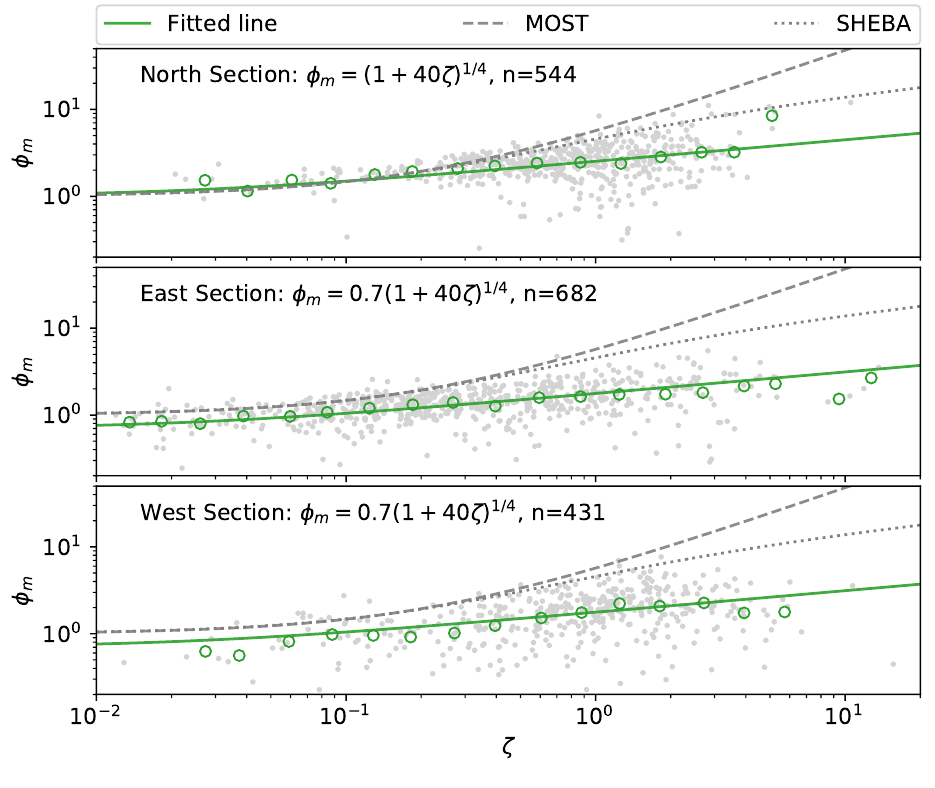
Figure 6. Plots of φ m of different models as functions of ζ : dots (measured data) and circles (bin-averaged measured data). n is the number of the measured